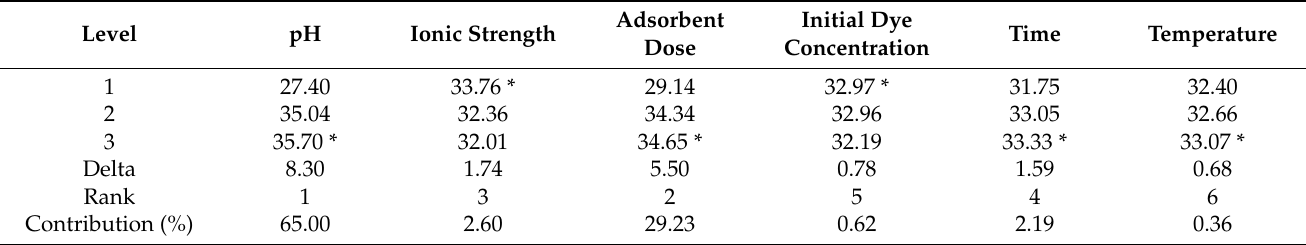
Table 7. Response table for signal-to-noise S/N ratios (larger is better) and contribution percentage of controllable factor influence on crystal violet removal